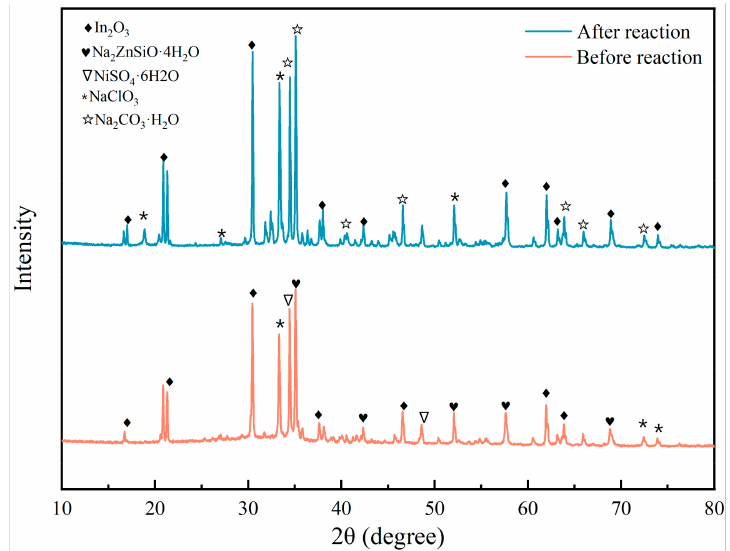
Figure 5. XRD of NaAlO 2 before and after the